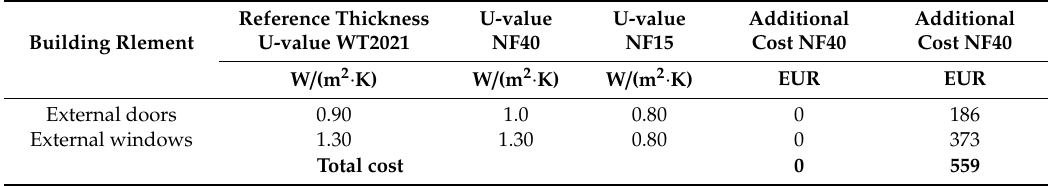
Table 15. Additional cost of external windows and doors for the NF40 and NF15